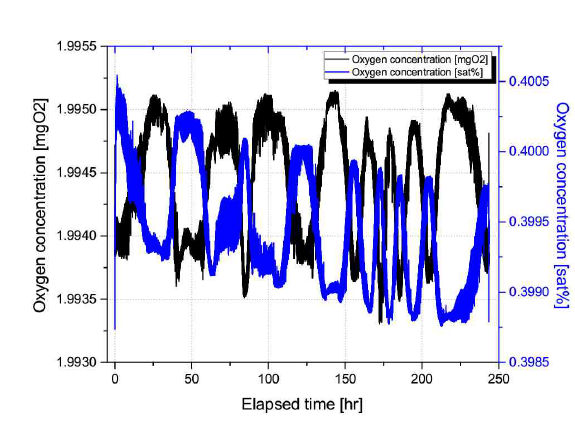
Figure 9. FeCrAl+Mo Run 1 - oxygen concentration.